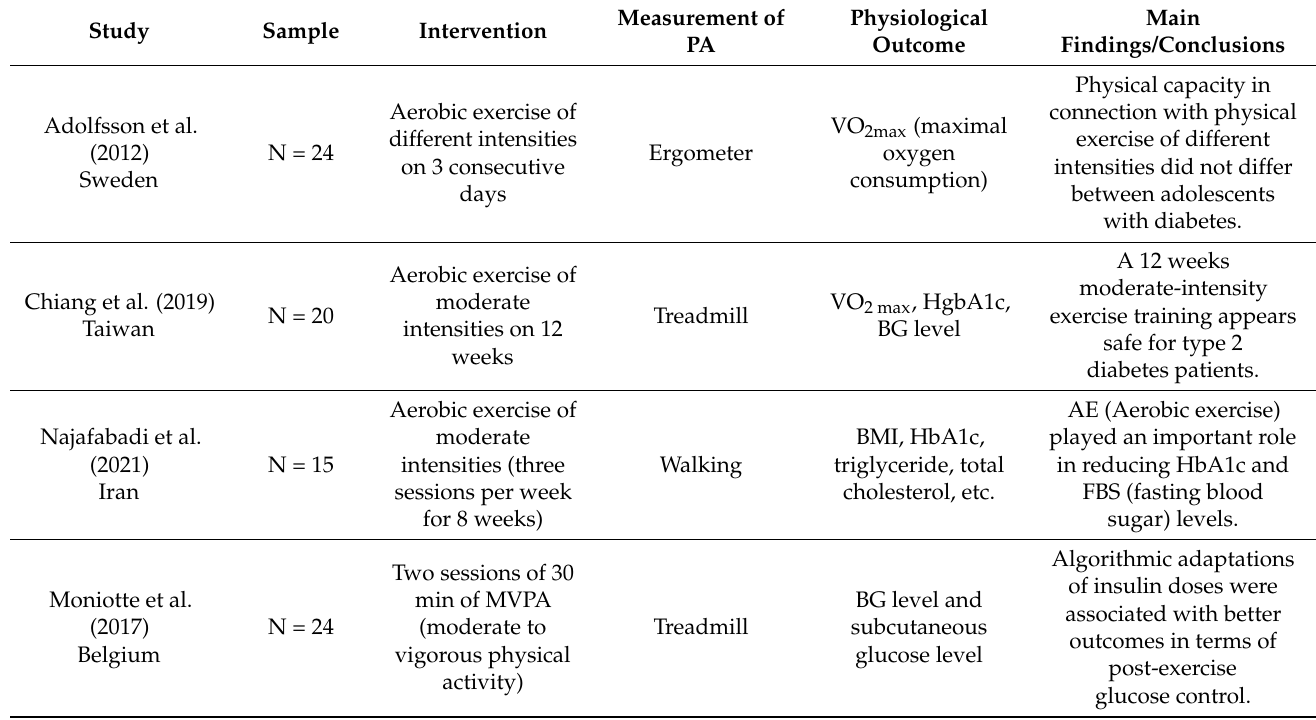
Table 1. Research comparisons according to exercise type, intensity, and frequency.